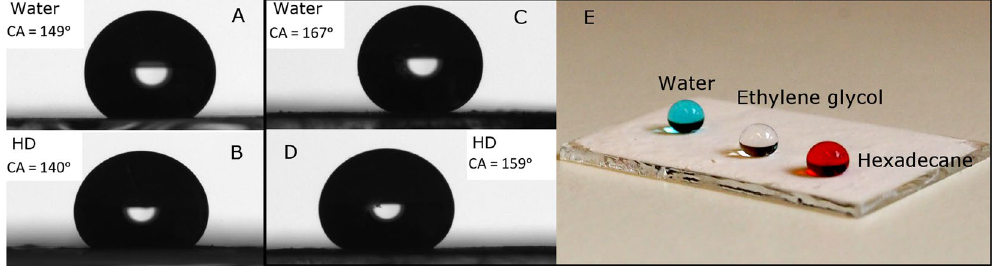
Figure 3. Static contact angle (SCA) of water and hexadecane (HD) on top of two different capsule-coated glass-surfaces, prepared using the capsules in Fig. 2A,B (images 3 A and 3B) and capsules in Fig. 2C,D (images 3 C and 3D). In ( E ) the same coating as in ( C ) and ( D ) is presented with 10 µ l drops of MilliQ-water, ethylene glycol and